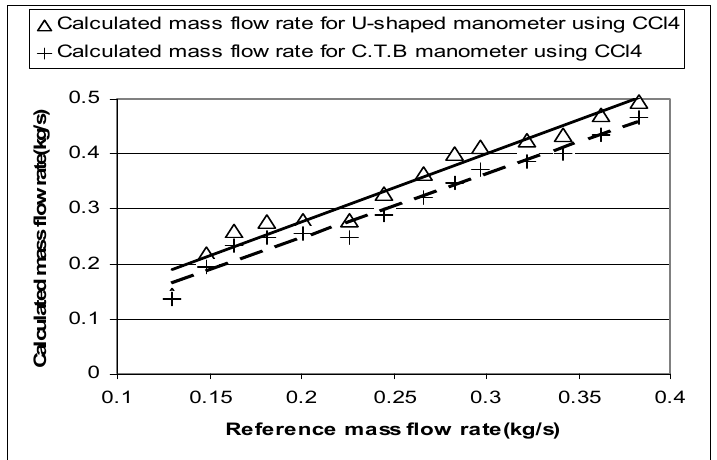
Figure 10 . Comparison between reference and calculated mass flow rates in case of venturimeter using CCl